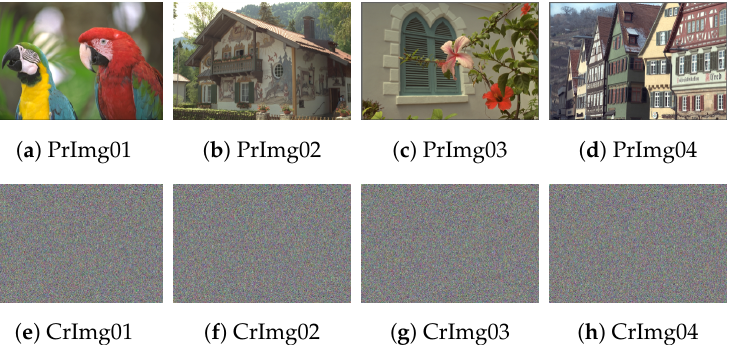
Figure 10. Experimented image dataset of dimensional 768 × 512, in which the first row denotes the plain images, while the second row describes the corresponding ciphered images.